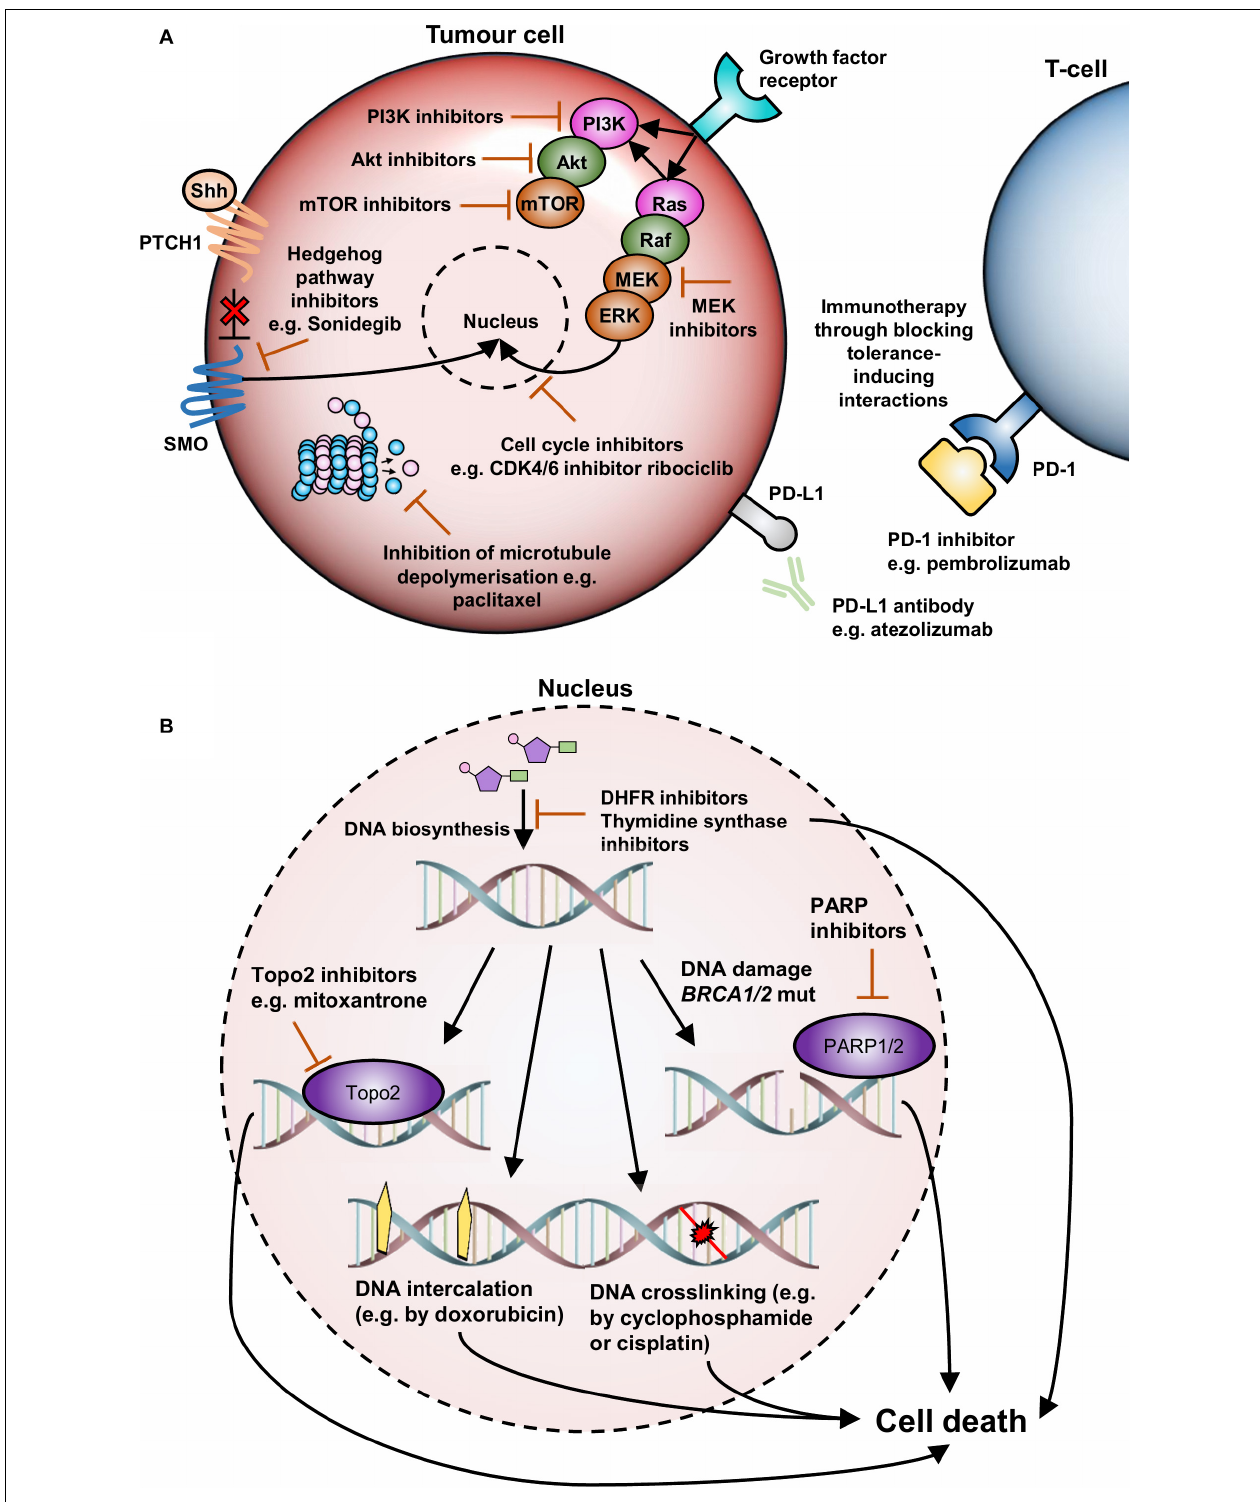
FIGURE 1 | An overview of current and emerging agents for TNBC therapy. (A) TNBC therapies targeting the cell surface and cytoplasm. Cell surface therapies include inhibitors of immune tolerance inducing proteins such as PD1 and PD-L1. Cytoplasmic therapies include inhibitors of the Ras/MAPK pathway, especially MEK inhibitors, inhibitors of the PI3K/AKT/mTOR pathway, inhibitors of the Hedgehog signaling pathway, and cell cycle inhibitors such as paclitaxel and CDK inhibitors. (B) TNBC therapies targeting the nucleus. These therapies tend to target DNA synthesis and repair pathways or affect DNA viability to induce cell-cycle arrest and cell